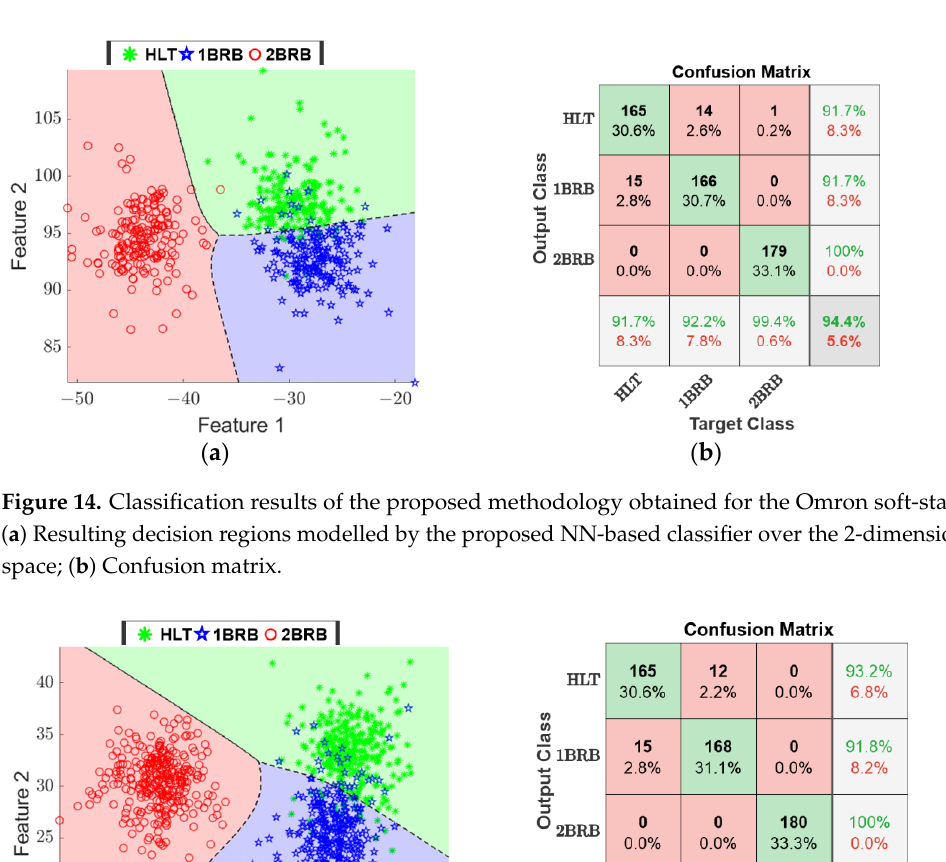
Figure 13. Classification results of the proposed methodology obtained for the ABB soft-starter. ( a ) Resulting decision regions modelled by the proposed NN-based classifier over the 2-dimensional space; ( b ) Confusion matrix.